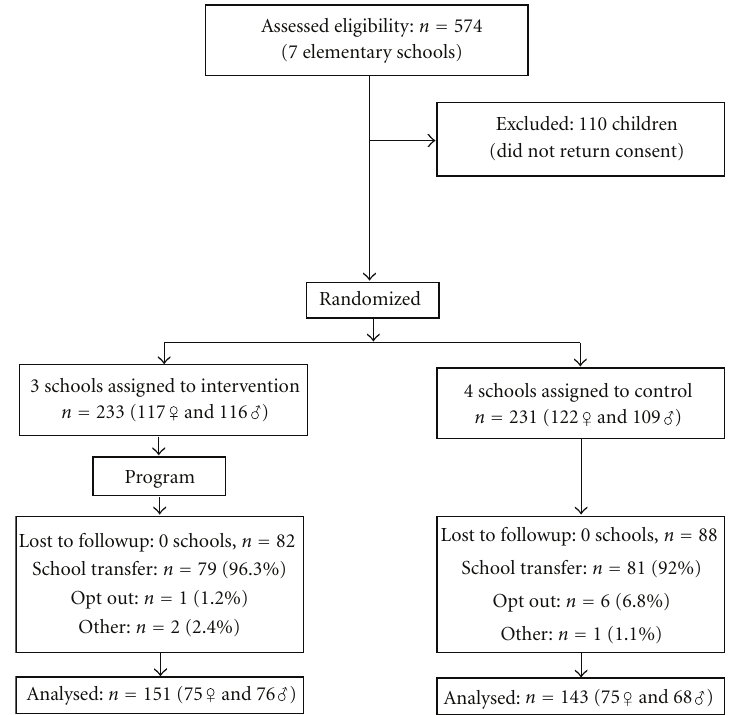
Figure 1: Flow of participants through each stage of the